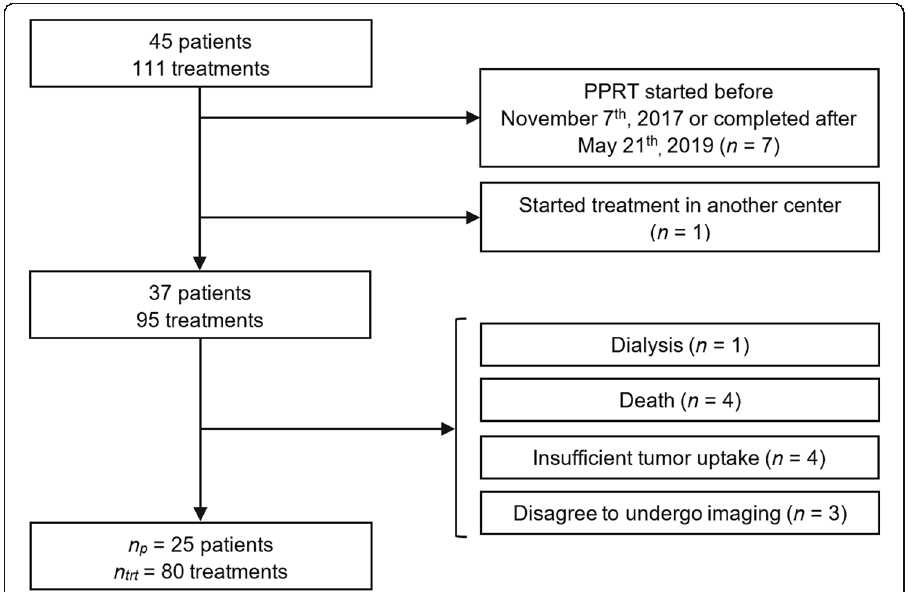
Fig. 1 Chart of patient inclusion. n p represents the number of patients included in the study and n trt is the corresponding total number of therapy